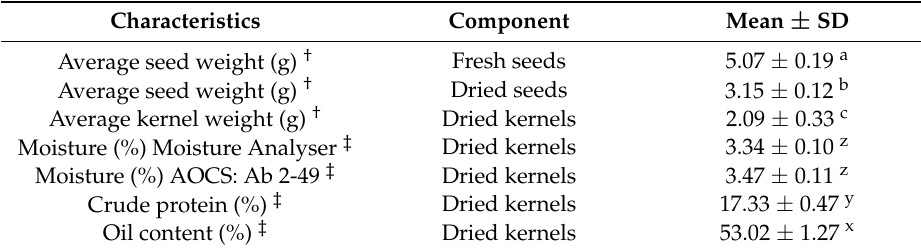
Table 1. Proximate analysis of dried Gac